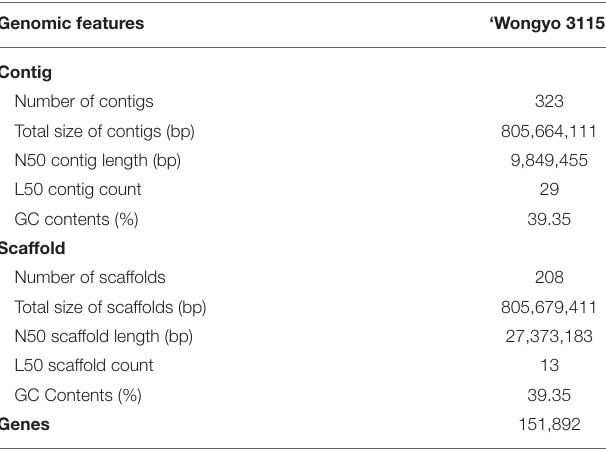
TABLE 1 | Assembly and annotation statistics of ‘Wongyo